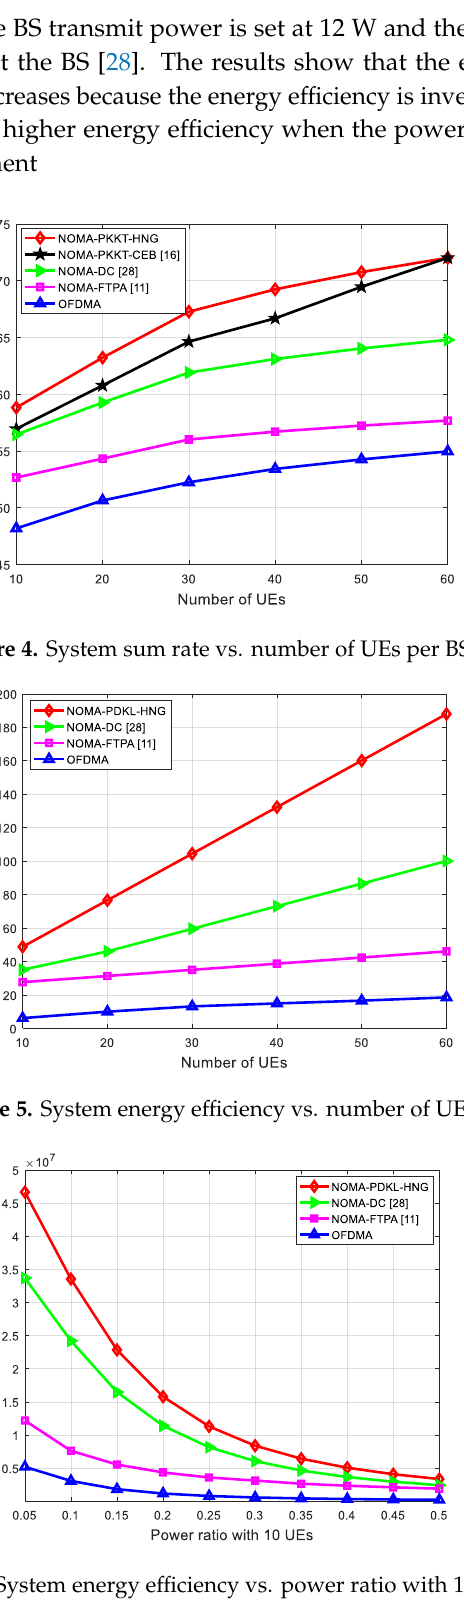
Figure 7. Fairness vs. number of UEs. Figure 8. Fairness vs. BS power with 10 UEs.